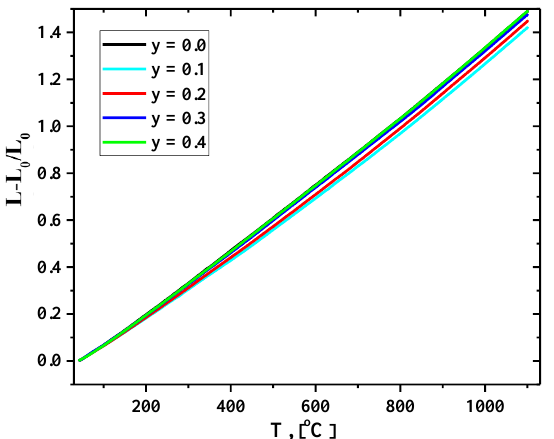
Figure 6. Temperature dependencies of the relative elongation of the La 1.7 Cа 0.3 Ni 1−y Cu y O 4+δ ceramic samples collected in a heating mode.